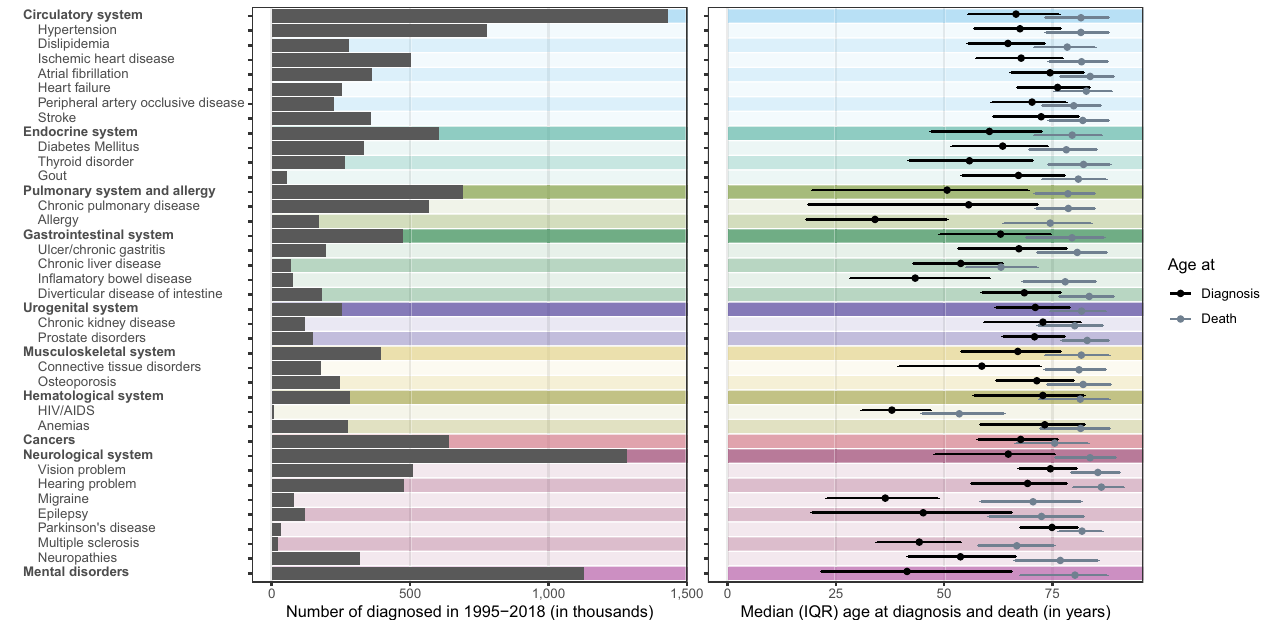
Fig 1. Number of diagnosed (left panel) and age at diagnosis and death among the diagnosed (right panel) for 39 selected conditions covering 10 broad categories. Estimates are available in S4 Table. I AU : AbbreviationlistshavebeencompiledforthoseusedthroughoutFigs 1 (cid:0) 5 : Pleaseverifythatallentriesarecorrect : QR, interquartile range.